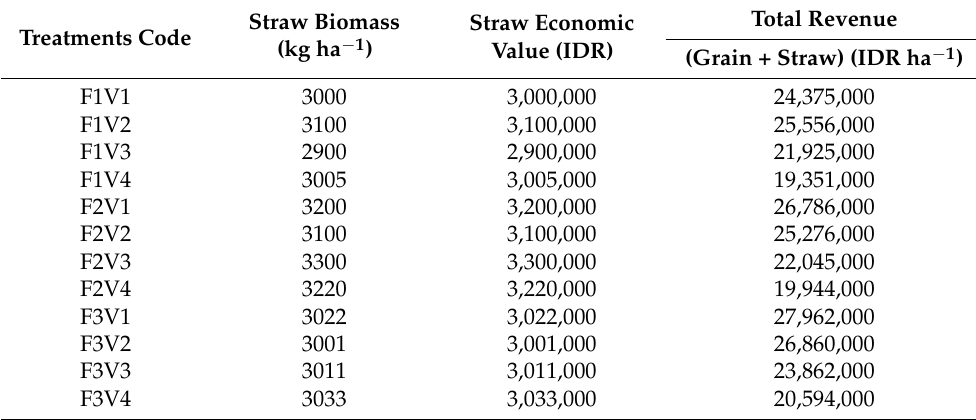
Table 9. Straw biomass and its economic value of the study in karst dryland, in